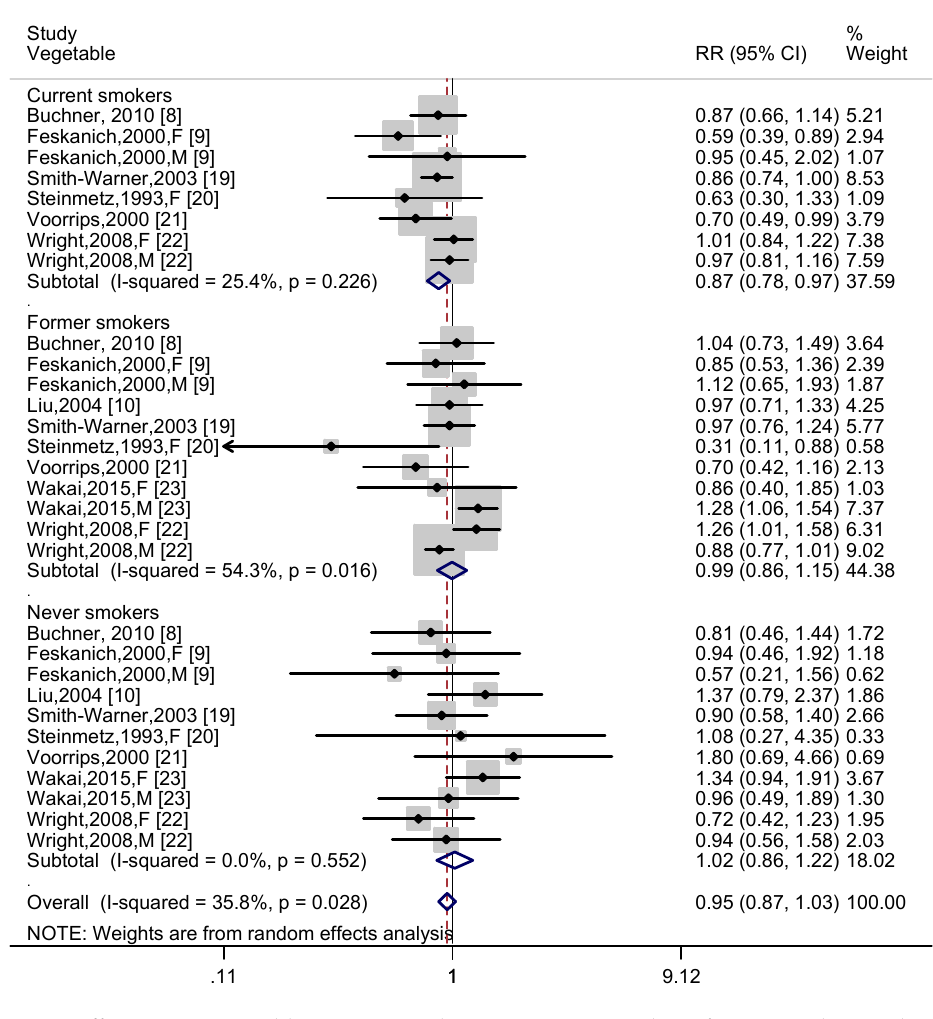
Figure 5. Differences in vegetable composition between current smokers, former smokers and never smokers. The pooled effect was calculated using a random-effects model. The diamonds denote summary risk estimate, and horizontal lines represent 95% CI. Abbreviations: F—female; M—male; RR—relative risk.